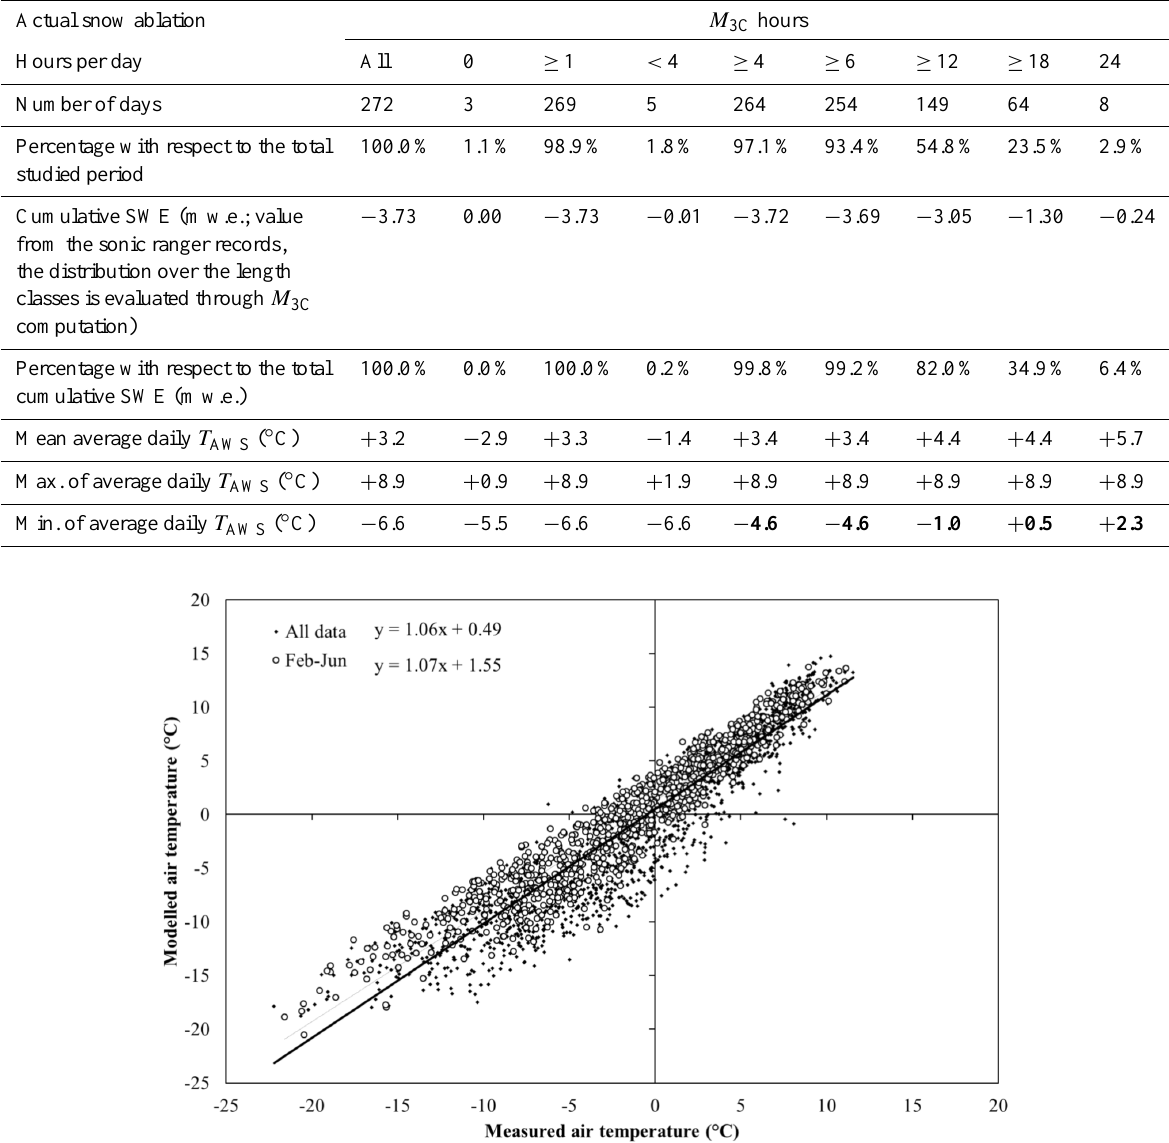
Table 4. Number of days and daily temperature values (mean, maximum and minimum of the average data) during an actual snow ablation period from 2006 to 2010 (i.e., the time frame between the beginning of the diminishment of the snow depth indicated by sonic ranger data and bare ice exposure derived from albedo values) considering different temporal length classes of M 3C hours per day. The air temperature data are recorded by AWS1 Forni ( T AWS ). The bold values are the ones chosen as possible T t in the T -index model for estimating actual snow ablation.